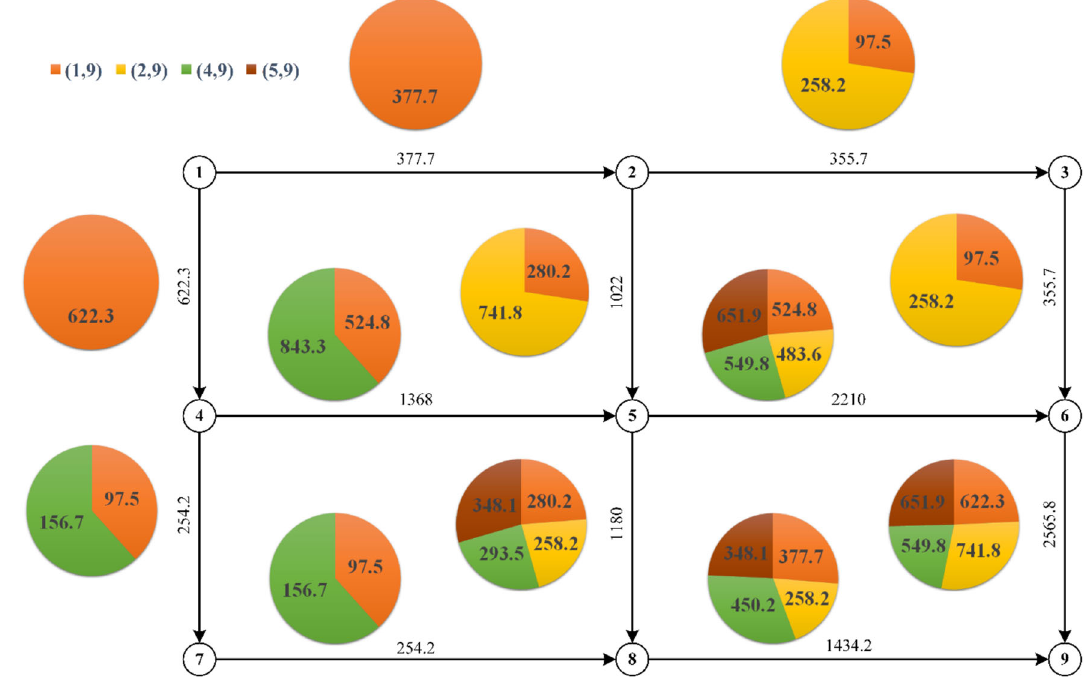
Fig. 4 Sources and composition of each link